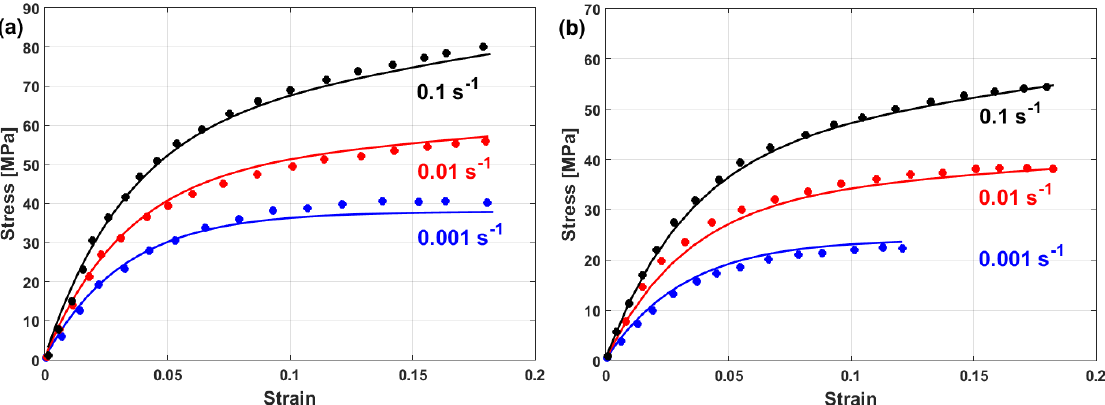
Figure 22. Experimental stresses (markers) compared to predicted stresses (solid lines) using the modified JC that was presented by Wang et al. [77] for 30Cr2Ni4MoV rotor steel at ( a ) 1323 K and ( b ) 1423 K.